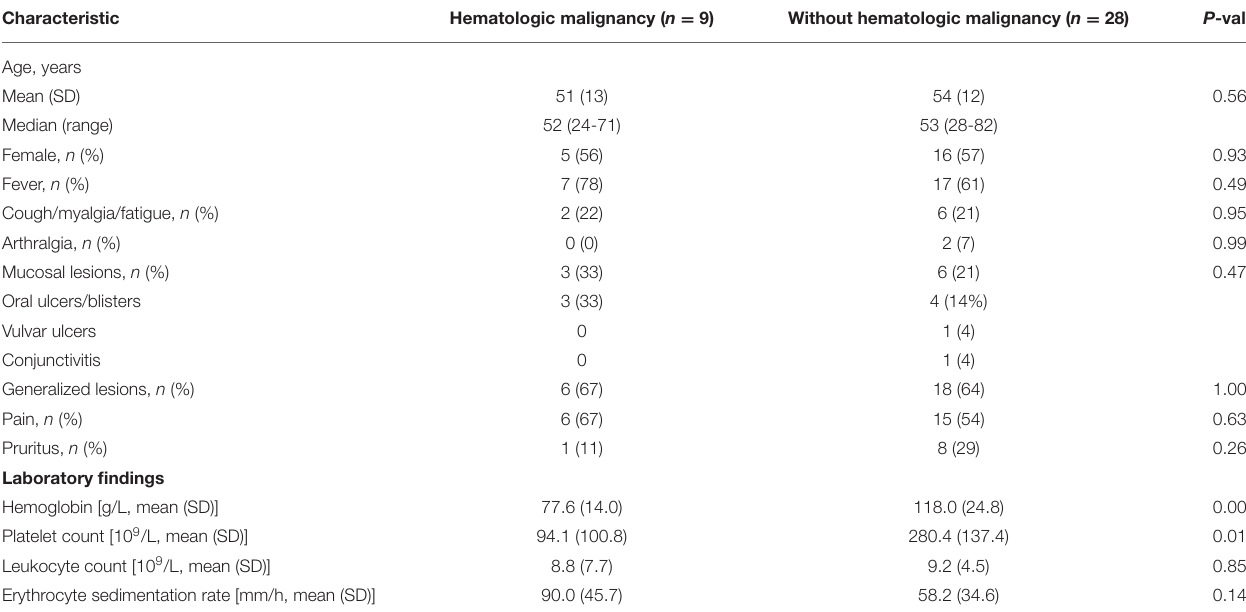
TABLE 1 | Sweet syndrome in patients with and without hematologic malignancy. Characteristic